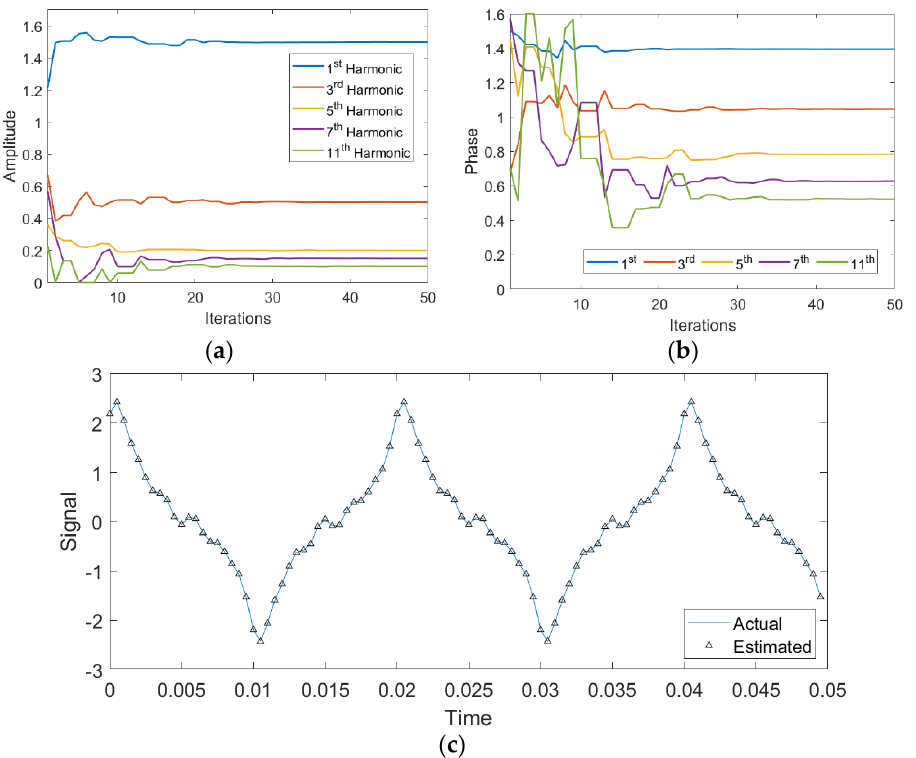
Figure 7. Plots of parameters estimate for 0.7 λ and 70 dB δ . ( a ) amplitude ( b ) phase ( c ) curve-fitting.